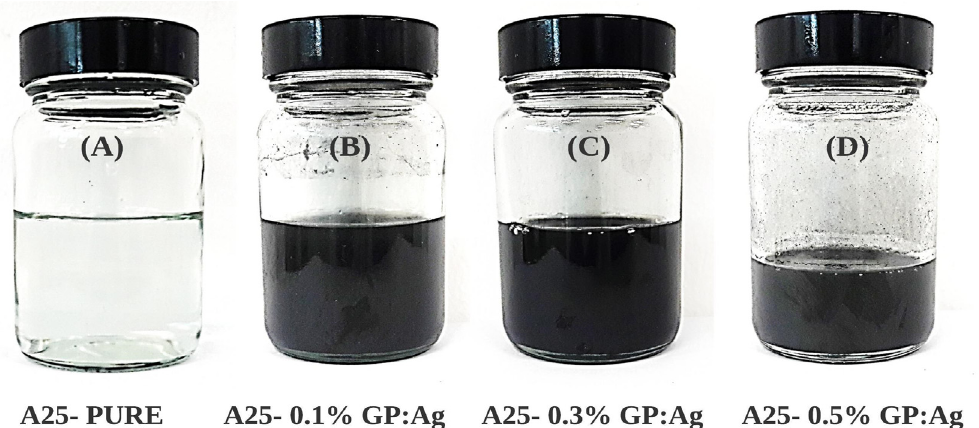
Figure 2. Images of pure and synthesized hybrid nanocomposites.